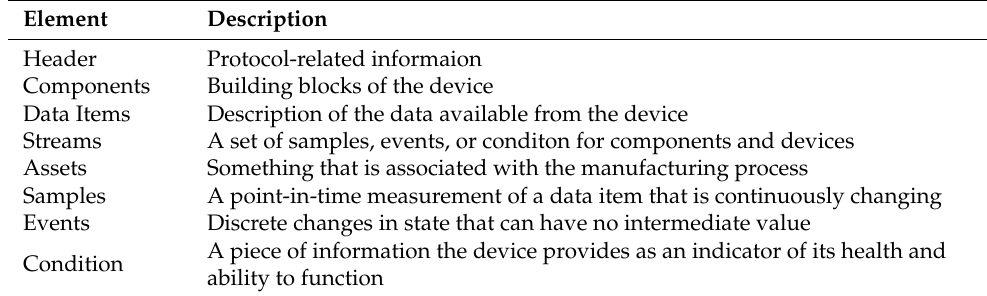
Table 1. MTConnect structure.